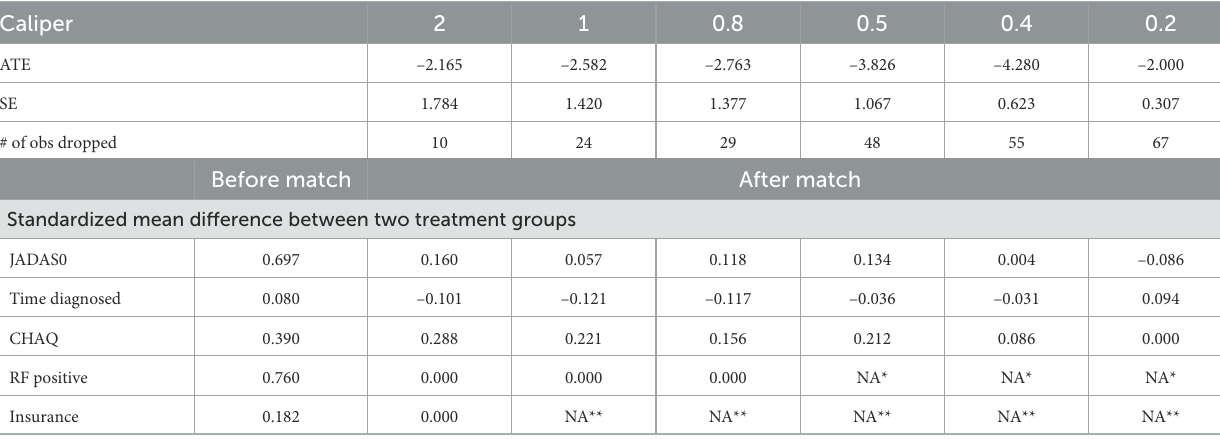
Before match Standardized mean difference between two treatment